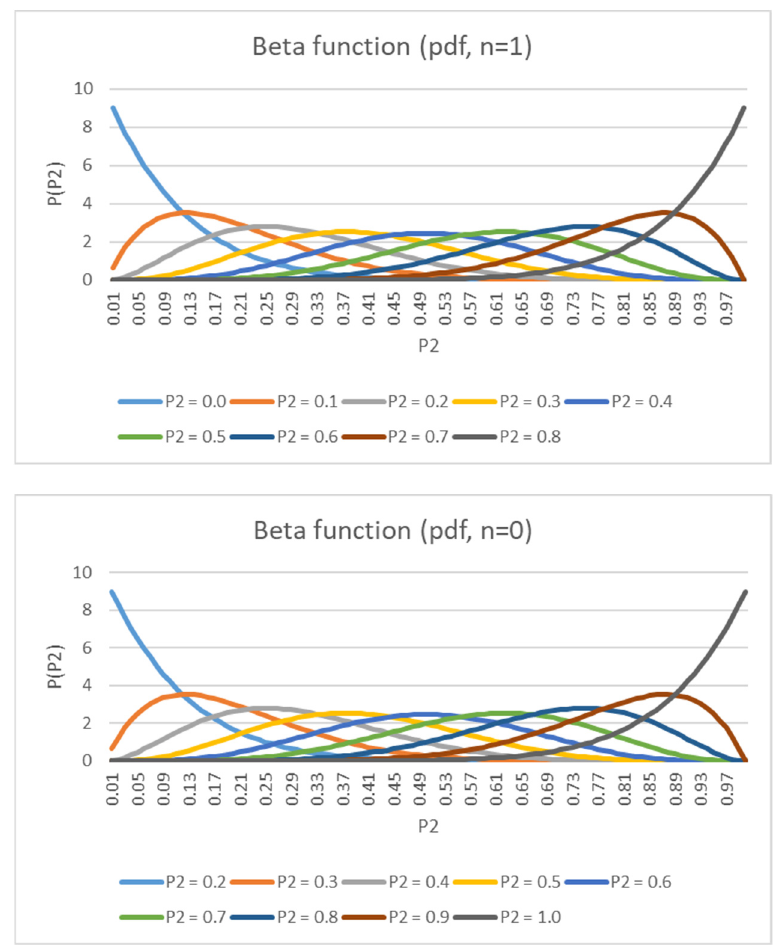
Figure 6. PDF of posterior ( n = 1) and PDF of posterior ( n = 0). Based on the threshold setting and the output of AMPD, P ( i ) and 0 (i.e., if P is greater than the threshold, change it to 1; otherwise, change it to 1